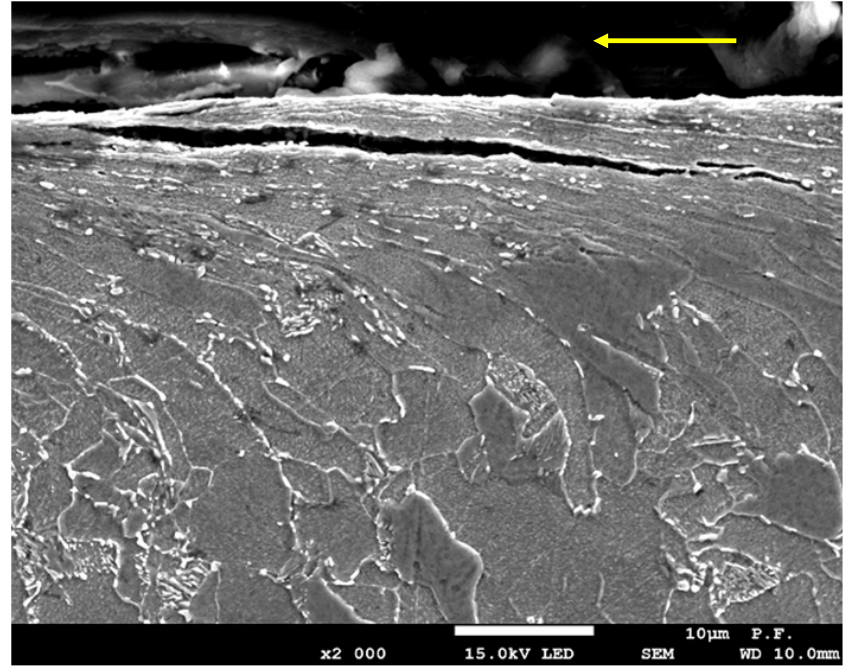
Figure 6. Metallographic microstructure of the cross-sectional area of cut produced at a high-power density of the jet (a pressure of 380 MPa and a cutting speed of 250 mm/min); cementite decomposition visible.